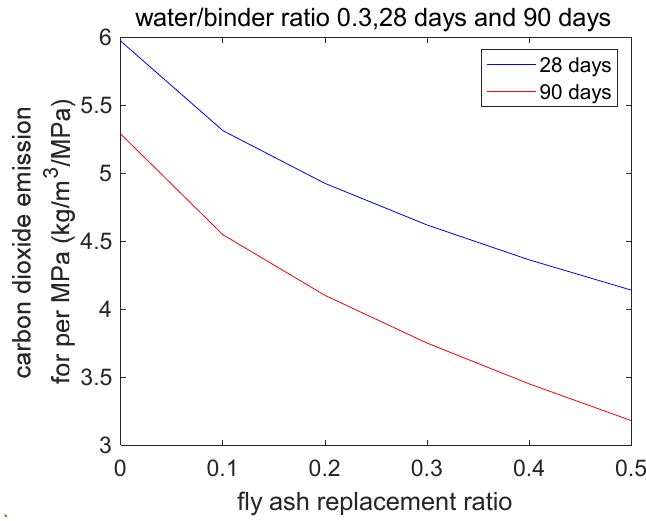
Figure 9. Effect of design age on CO 2 emissions for 1 MPa strength.